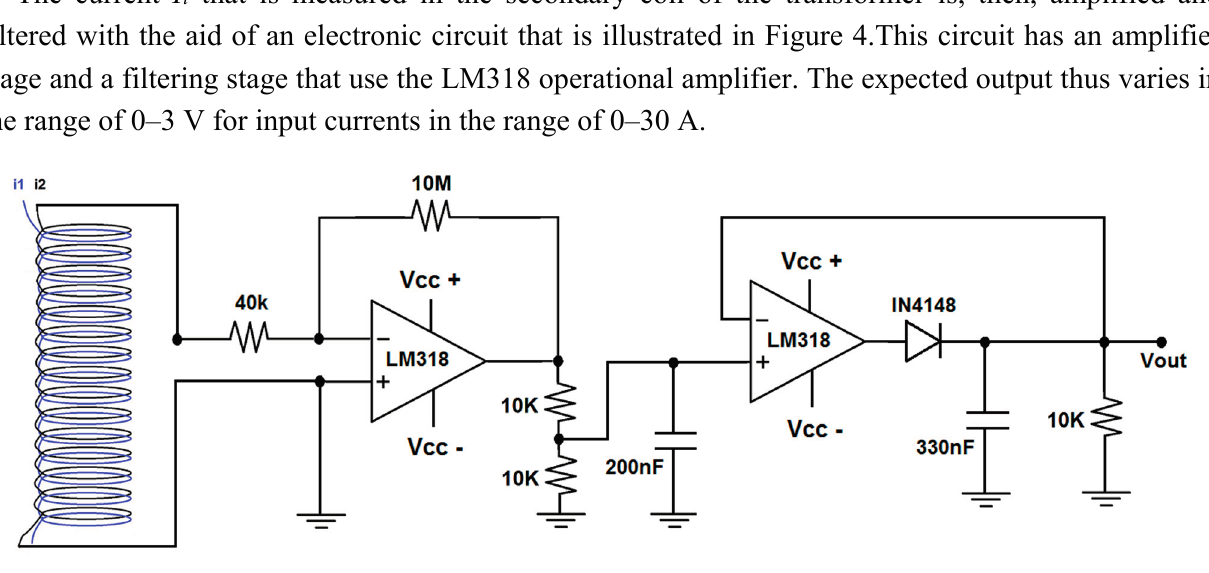
Figure 4. Electronic circuit of the amplifying/filtering stage connected to the current sensor (air-core